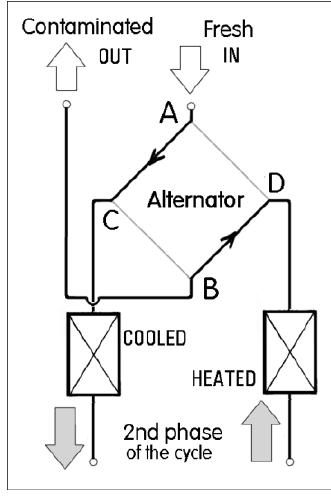
Fig. 20. Topology of the pair of regenerator exchangers with the air flow switched by a fluidic two-phase alternator [21]. Fresh air flows through A .